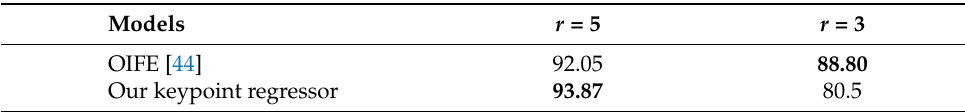
Table 3. Comparisons (%) of the prediction accuracy of keypoint regressor on VeRi-776 dataset. The best results are shown in bold.